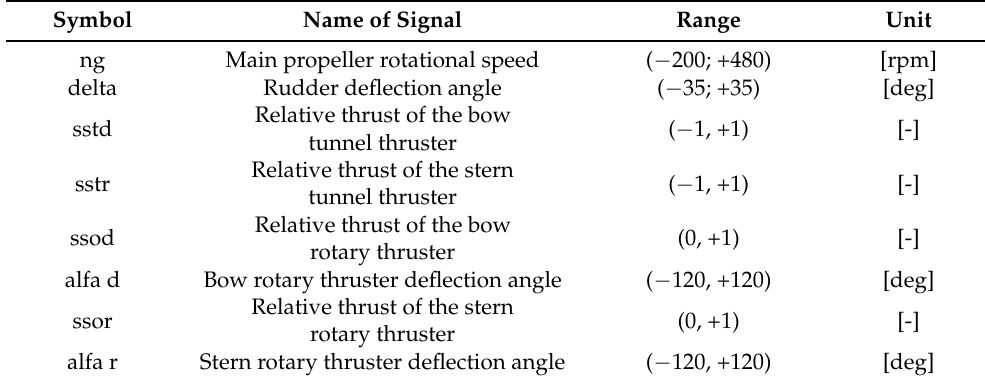
Table 1. Input signals of propulsion and control devices of the “B LUE L ADY ” ship model.